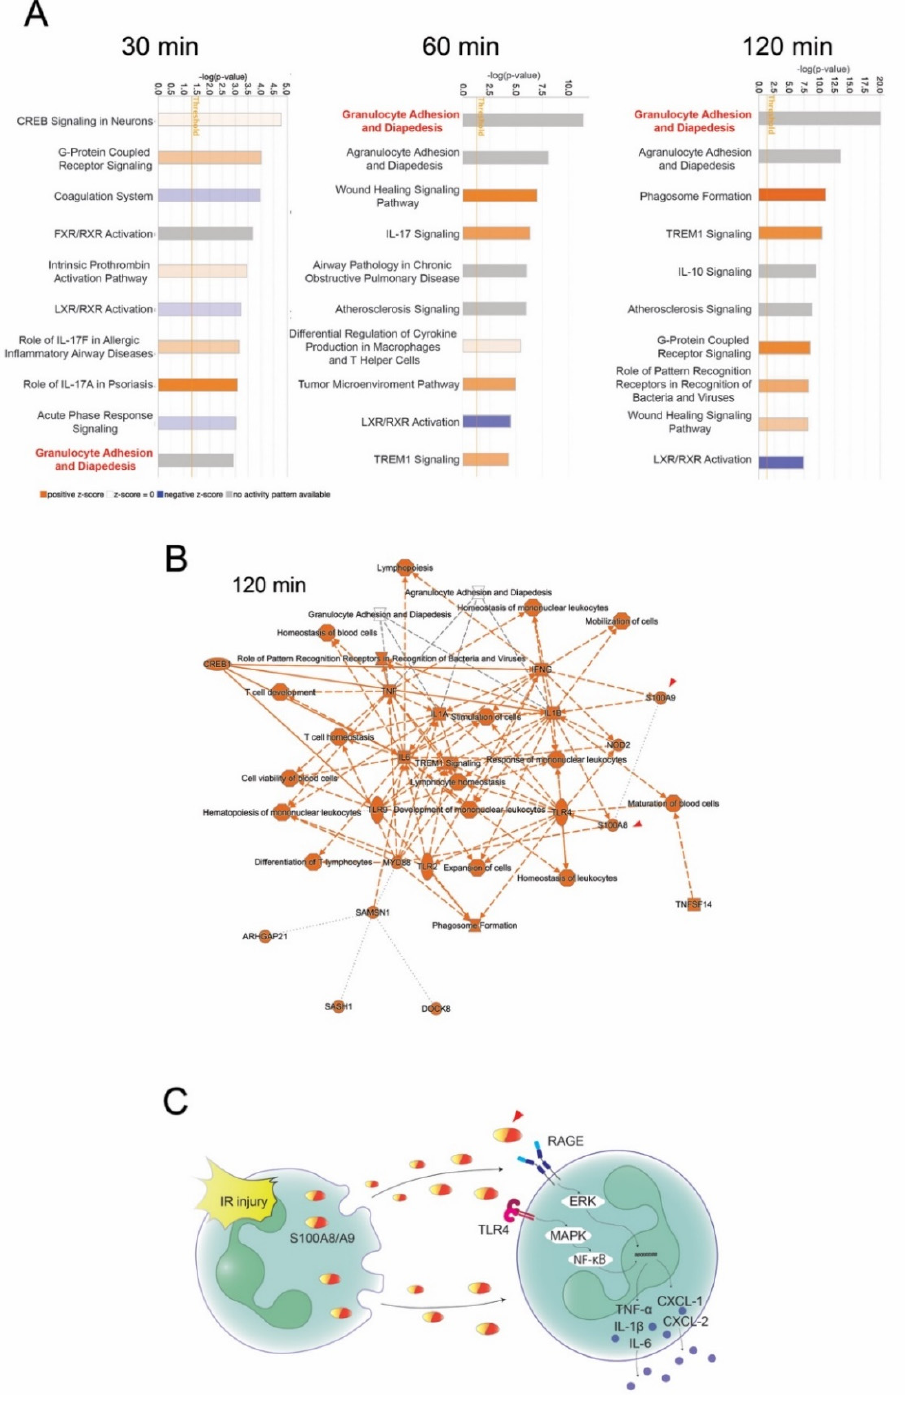
Figure 2. Gene enrichment analysis and signal maps of RNA sequencing data. ( A ) Ten enriched gene ontologies based on a canonical pathway database. Arrowheads indicate granulocyte adhesion and diapedesis signaling at 30, 60, and 120 min after IR injury. ( B ) A visual network of gene expression profiling at 120 min after IR. Arrowheads indicate the S100 genes. ( C ) A suggested schematic diagram of critical signal events of IR injury in the lung.